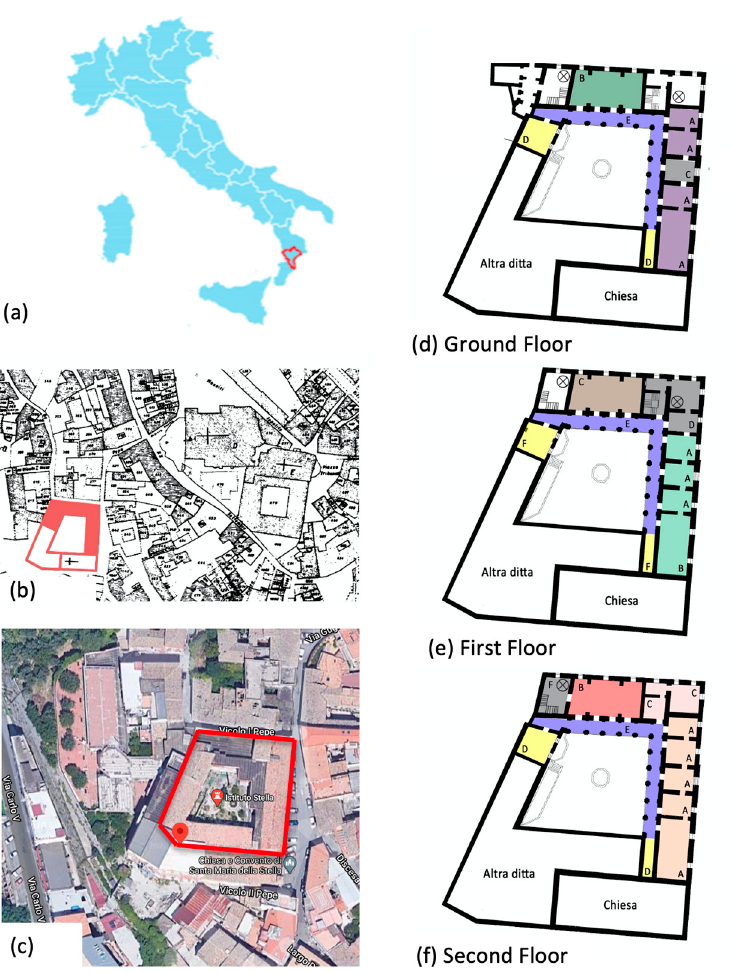
Figure 1. ( a – c ) location. ( d – f ) Current functional distribution for each level of Palazzo Stella in Figure 1. ( a ), ( b ), and ( c ) location. ( d ), ( e ), and ( f ) Current functional distribution for each level of Catanzaro Palazzo S tella in Catanzaro (Italy).